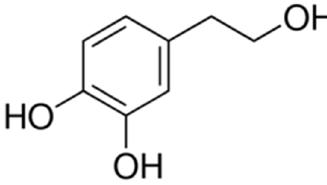
Figure 1. Chemical structure of hydroxytyrosol (HT).